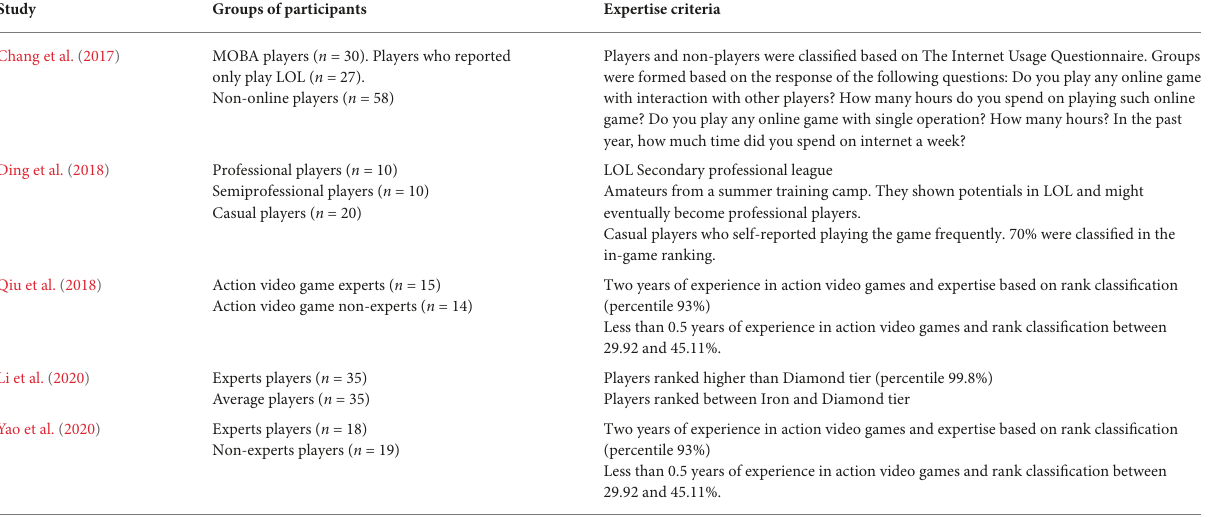
TABLE 1 Description of expertise criteria in LOL studies.